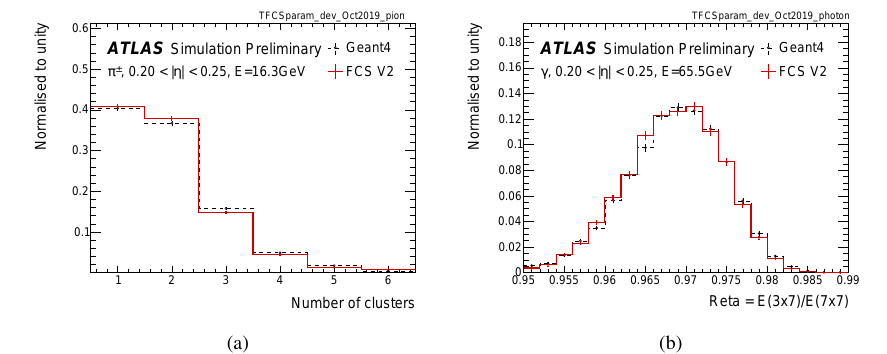
Figure 2. (a) Number of clusters produced by a 16 GeV pion in the range 0 . 20 < | η | < 0 . 25 in FastCaloSim v2 (red solid line) compared to G eant 4 (black dashed line). (b) Fractional deposited energy in the η direction for the second barrel layer of the electromagnetic calorimeter for a 65 GeV photon reconstructed cluster in the range 0 . 20 < | η | < 0 . 25. The 3x7 and 7x7 refers to the rectangle of cells considered around the cluster centre. FCSV2 (red solid line) is compared to G eant 4 (black dashed line). In both cases, the FastCaloSim v2 parametrisation from October 2019 is used. From Ref.